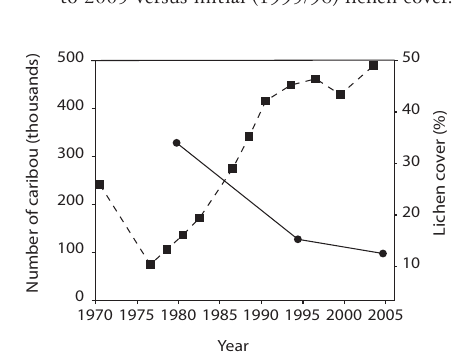
Fig. 5. The decline of lichen cover (solid line with circles) on the winter range of the WAH coincided with the rapid expansion of the number of individuals in the herd (dashed line with squares), northwest